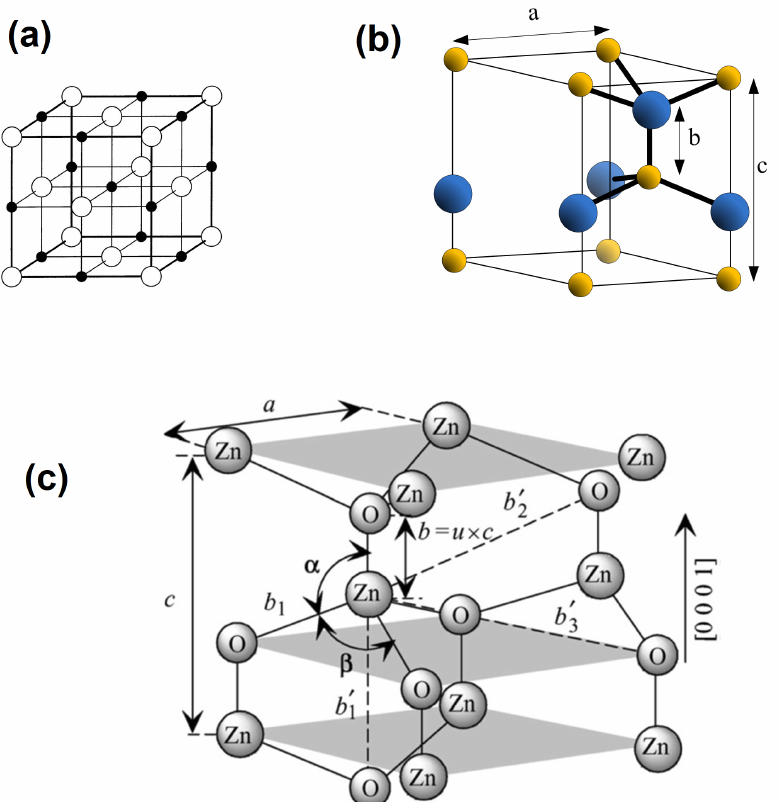
Figure 1. Structures of ZnO. In ( a ) cubic rocksalt, in ( b ) wurtzite hexagonal, and in ( c ) the wurtzite lattice constants a and c